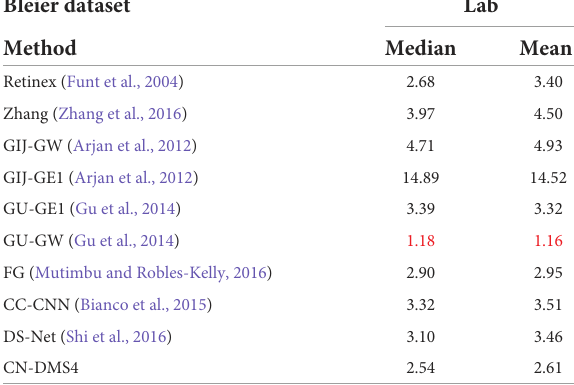
TABLE 3 Quantitative evaluation on Bleier (Bleier et al., 2011), red indicates the